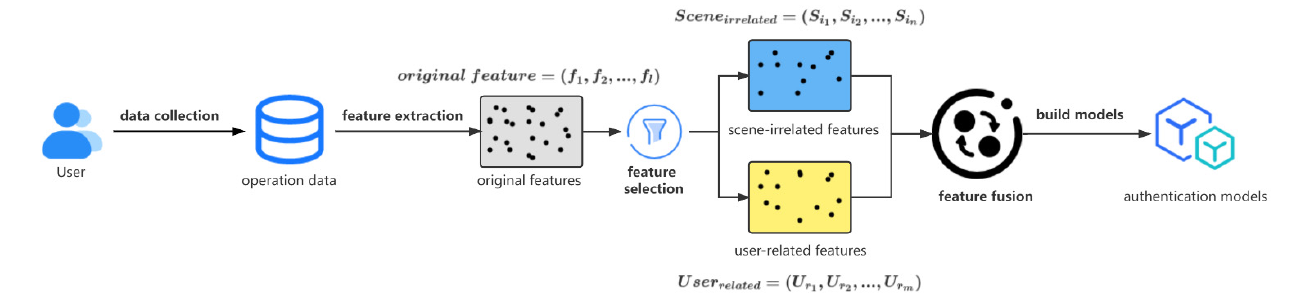
Figure 1. Block diagram of SIURUA.